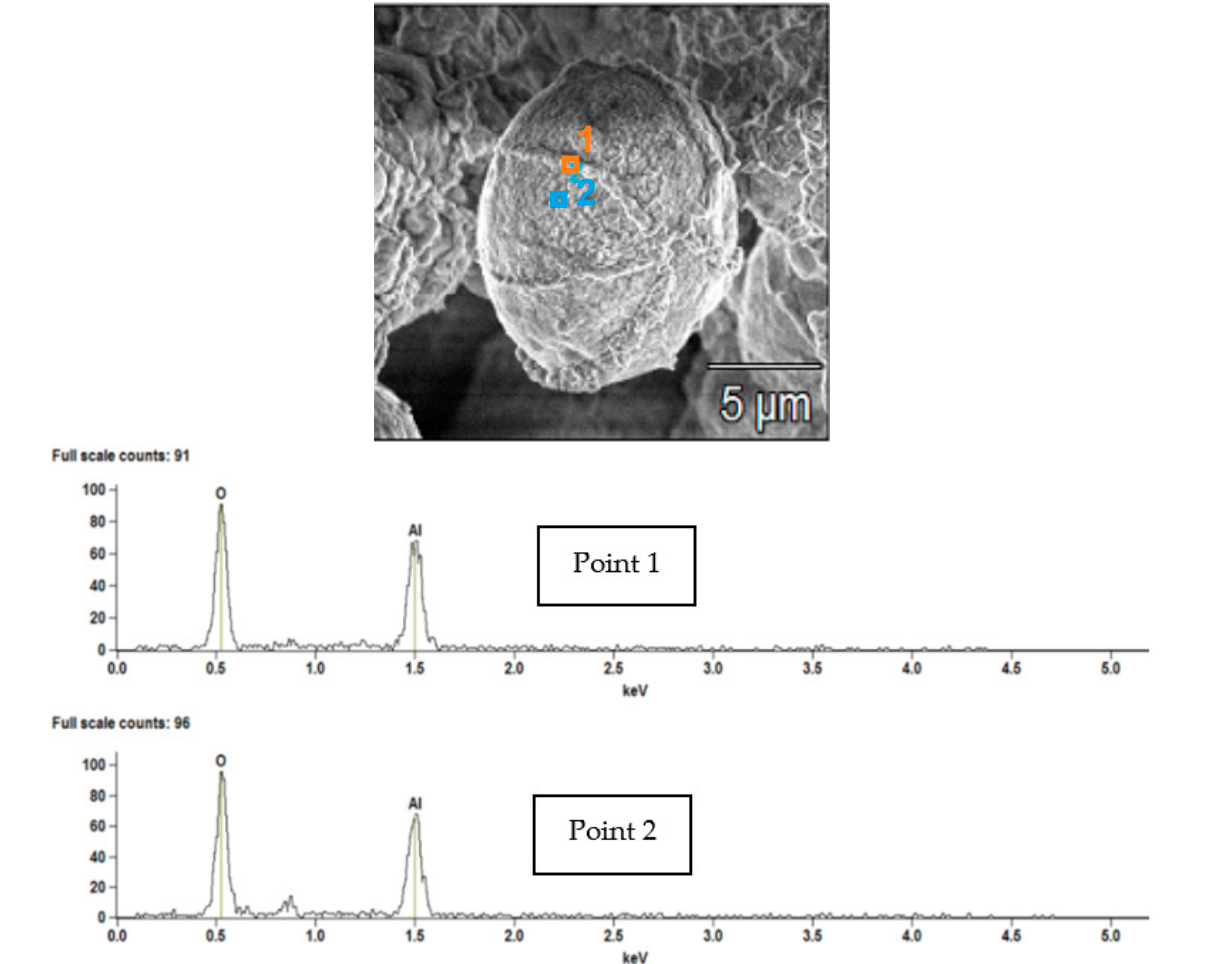
Figure 28. SEM and EDS for a particle in a cluster which had been dropped onto a Ni-chrome foil. The second experiment utilized a graphite resistance heater where aluminum particles were heated to the range 900–1200 ◦ C in increments of 50 ◦ C. The particles were dropped through the 12” long × 2” diameter (30.48 cm × 5.08 cm) graphite heater tube which allowed small clusters of powder to be captured at the bottom of the tube for study. The residue was examined by SEM to determine the state with regard to oxidation and physical appearance. It was noted that for the higher preheat temperatures, white smoke was observed emanating from the heater which may be either alumina smoke, or condensing aluminum vapor. Figures 29 and 30 show SEM and EDS images, respectively, for particles involved in some of the tests. The particles have the appearance of a deflated soccer ball with dimples indicating shrinkage after cooling. Shrinkage could be a consequence of cooling following thermal expansion of the oxide coating, or may be a consequence of aluminum vapor escaping from the particle. Since breaches in the oxide coating are not apparent, this may support the contention that the event was a simple thermal expansion following by cooling